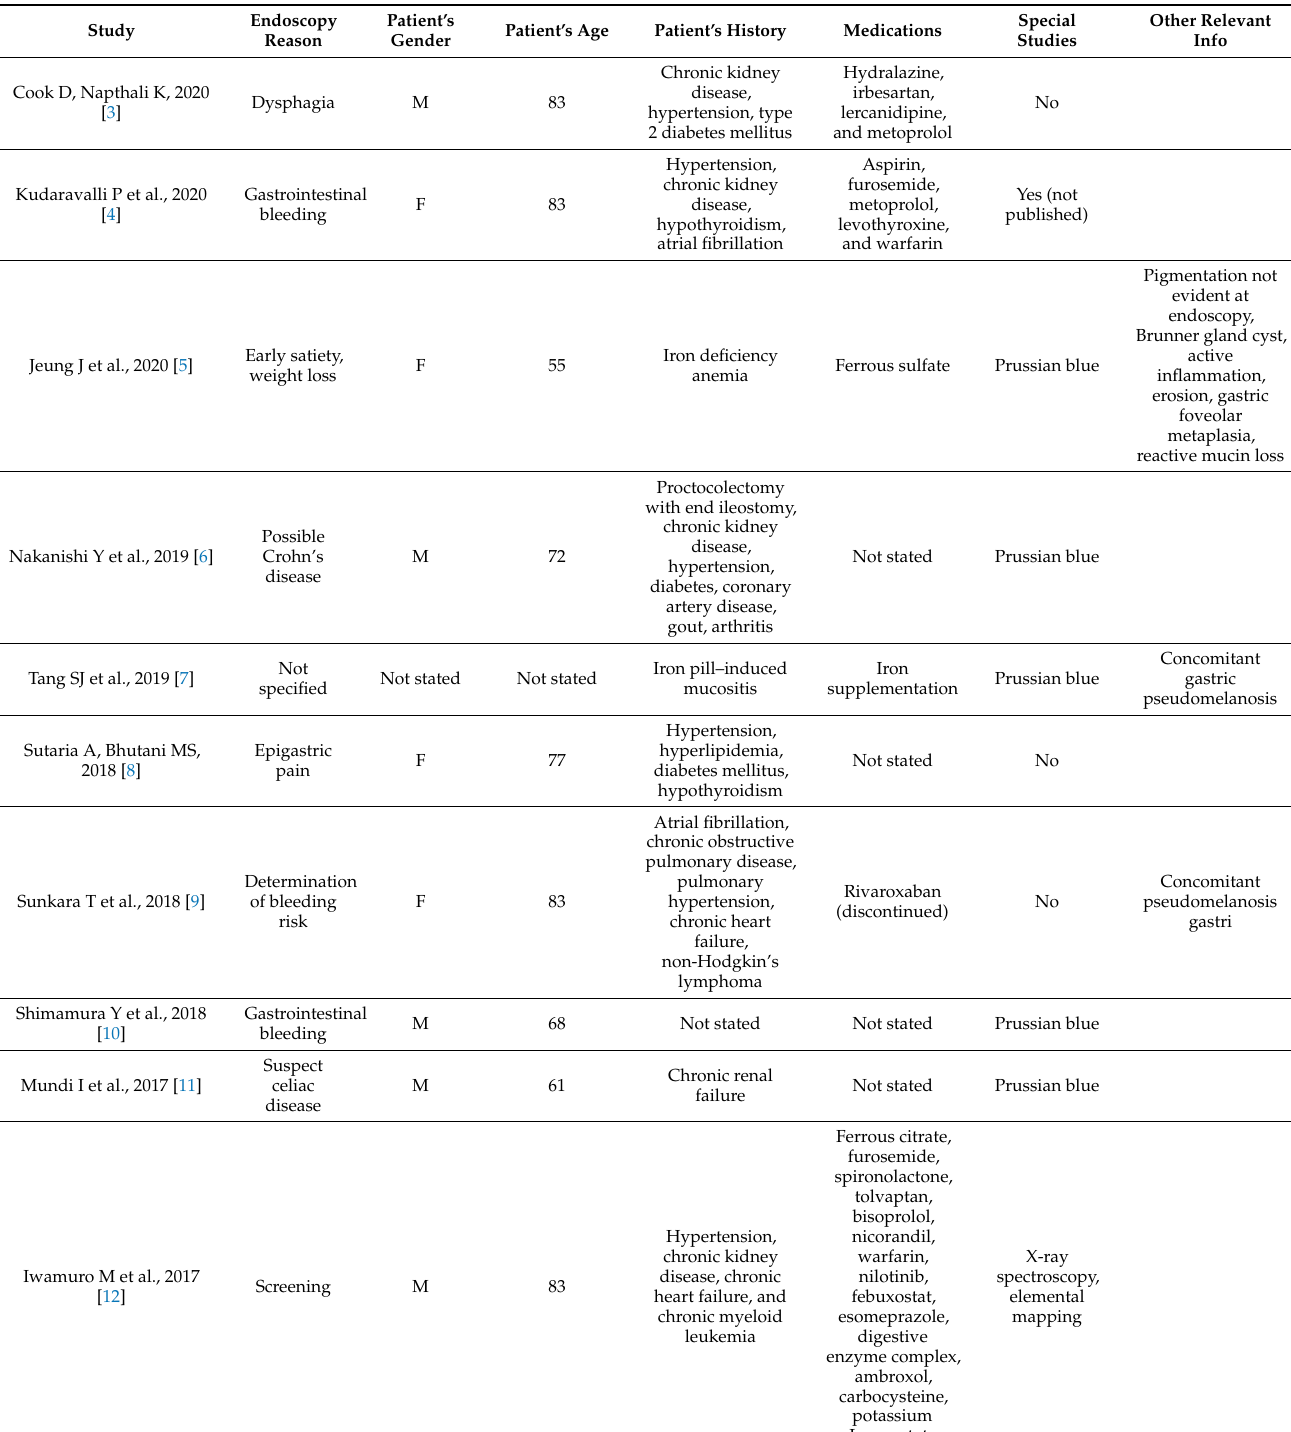
Table 1. Summary of the studies published between 2001 and 2021 describing cases of duodenal pseudomelanosis and